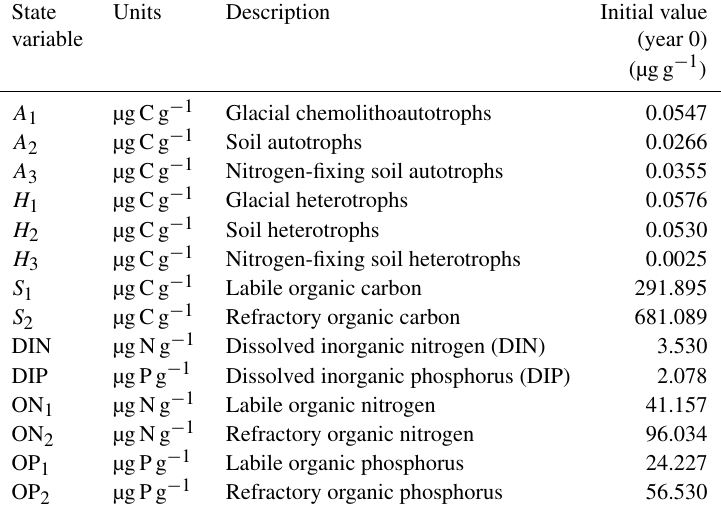
Table 1. State variables and initial